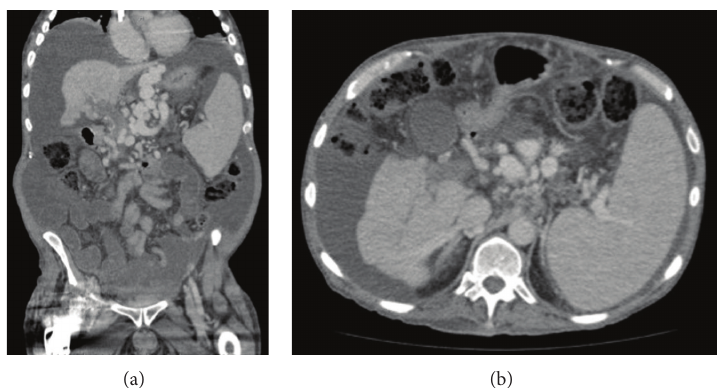
Figure 1: (a) CT abdomen/pelvis with and without contrast in coronal portal phase showing complete occlusion of the entire portal vein at the level of the confluence of the superior mesenteric vein and mild cavernous transformation of the main portal vein. Splenomegaly noted, measuring 19.6 cm in craniocaudal dimension with moderate to large ascites. (b) CT abdomen/pelvis with and without contrast in axial portal phase showing a cirrhotic liver with no arterial hyperenhancing hepatic lesion or lesion with washout. There are multiple calcifications in the main pancreatic duct at the neck resulting in dilatation of the pancreatic duct involving the body and tail measuring up to 1.3